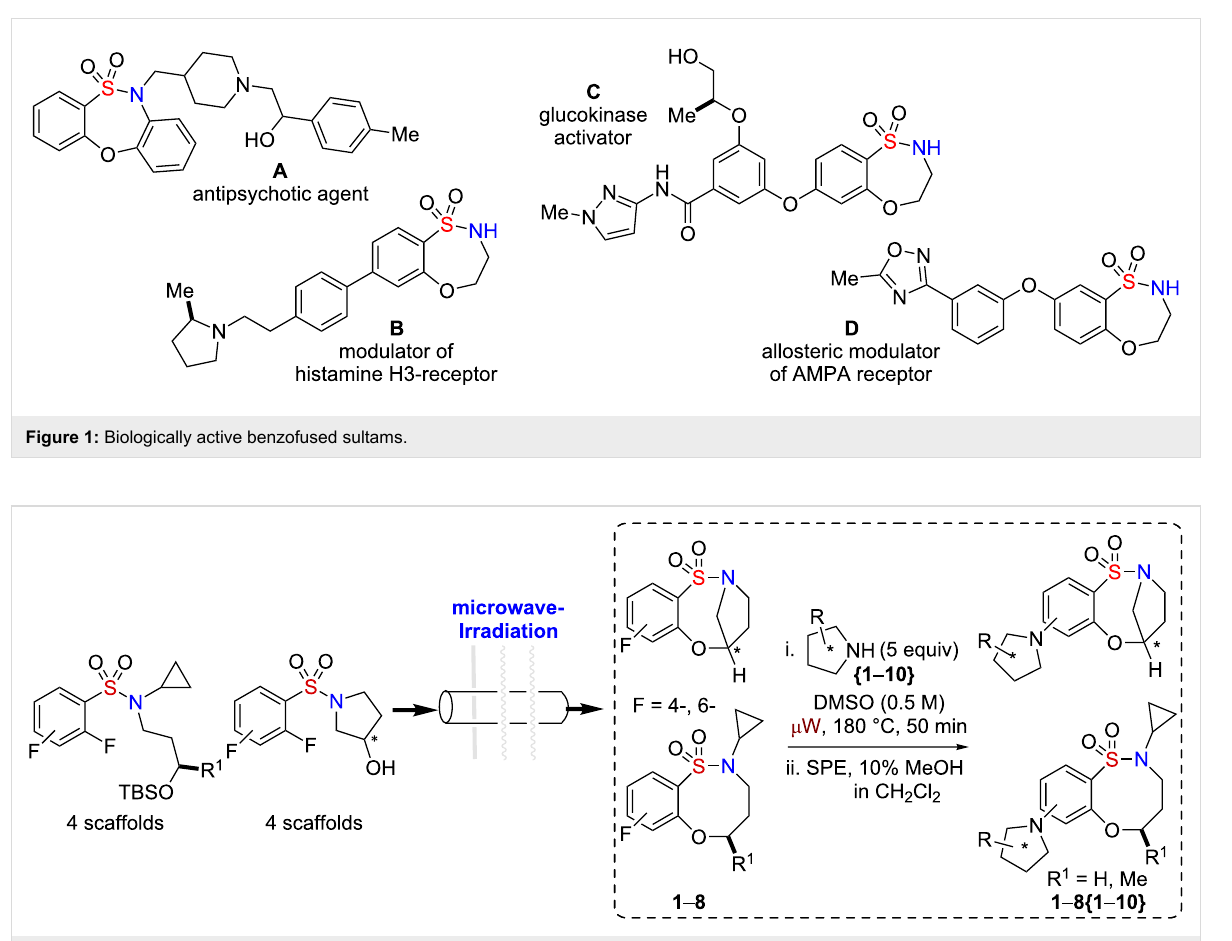
Scheme 1: Proposed library generation by microwave-assisted intermolecular S N Ar diversification